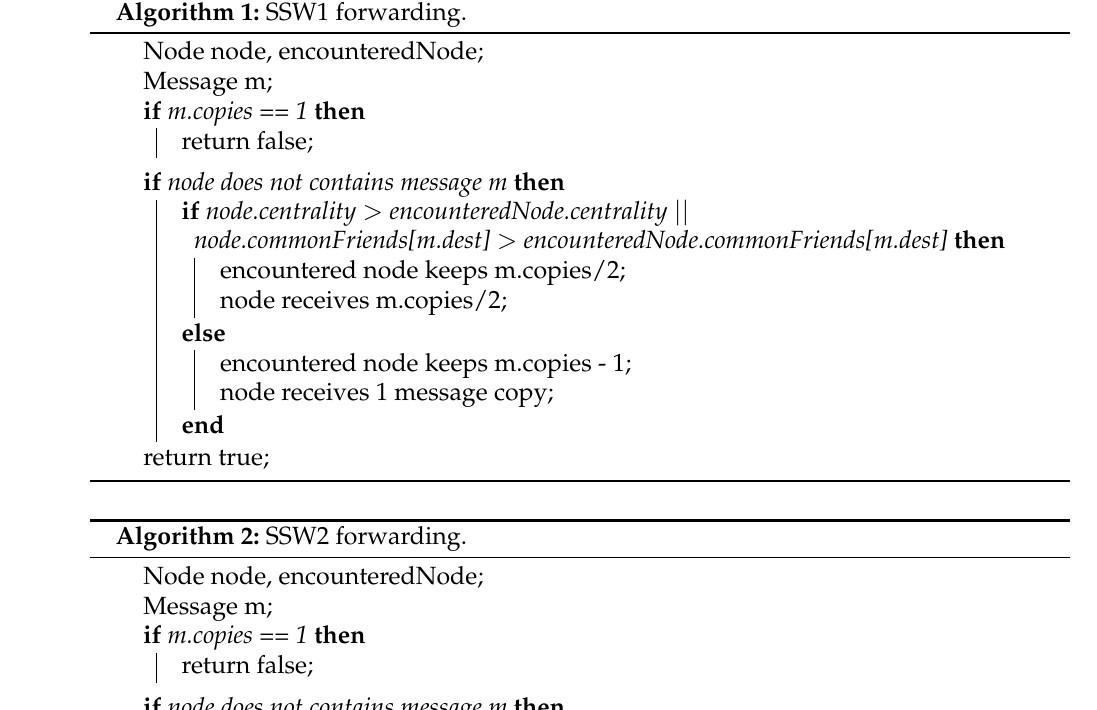
Algorithm 1: SSW1 forwarding.